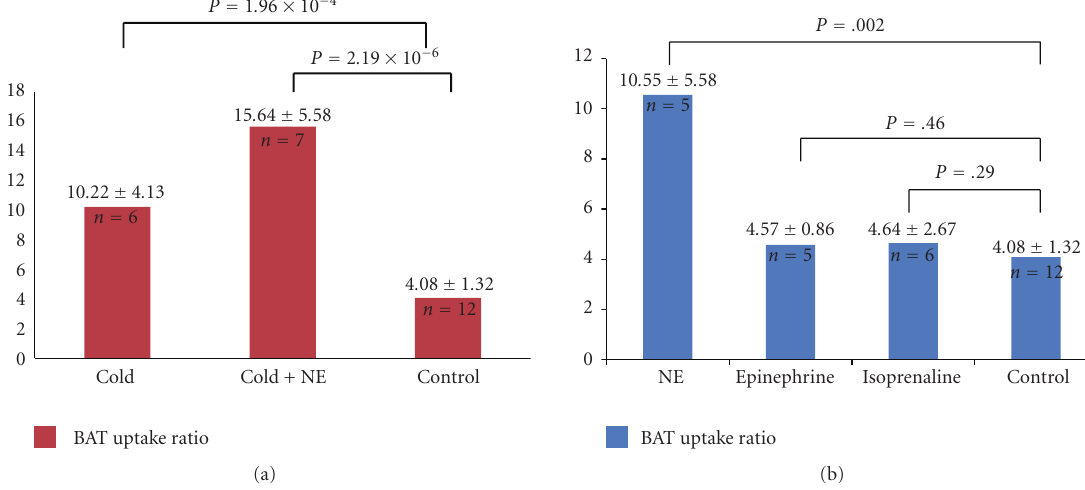
Figure 2: Comparison of the e ff ects of di ff erent interventions to stimulate interscapular BAT in mice. (a) BAT FDG uptake ratio in cold, cold + NE and control group. Cold together with NE intervention showed the highest uptake in BAT. (b) BAT FDG uptake ratio in NE, epinephrine, isoprenaline, and control group. All these pharmaceutics increase BAT activity, but only NE showed significant di ff erence ( P = .